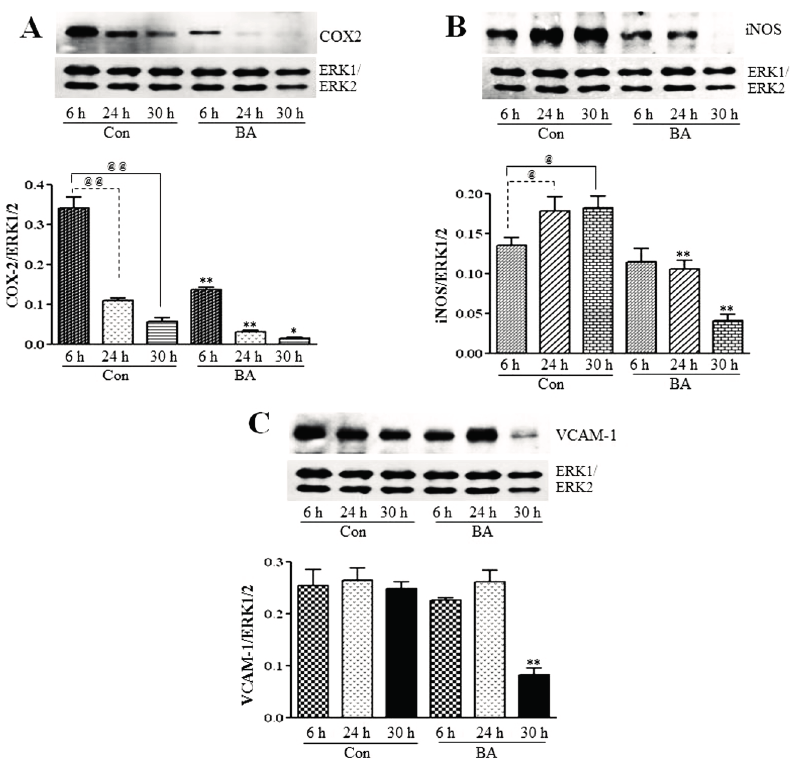
Figure 9. Inhibition of COX2, iNOS and VCAM-1 expression in butyrate-inhibited VSMC proliferation. After the indicated periods of treatment with (BA) or without (Con) butyrate, cell lysates were prepared and analyzed by western analysis to determine the effect of butyrate treatment on the expression of indicated proteins associated with inflammation. Band intensities are normalized to ERK1/ERK2 and displayed as a bar graph, respectively ( bottom ). Values shown are the mean ± SD of three independent experiments. ( A ) COX2 expression. @@ p < 0.001 vs. 6 h control, * p < 0.01 and ** p < 0.001 vs. respective controls. ( B ) iNOS expression. @ p < 0.01 vs. 6 h control, ** p < 0.001 vs. respective controls. ( C ) VCAM-1 expression. ** p < 0.001 vs. respective untreated